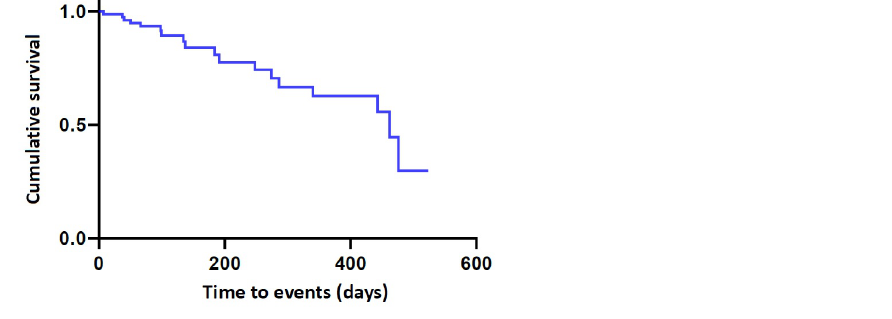
Figure 5. Kaplan–Meier cumulative survival. In our series, the time-to-events were estimated at 386.68 ± 27.79 days (95% CI 334.11–439.27).